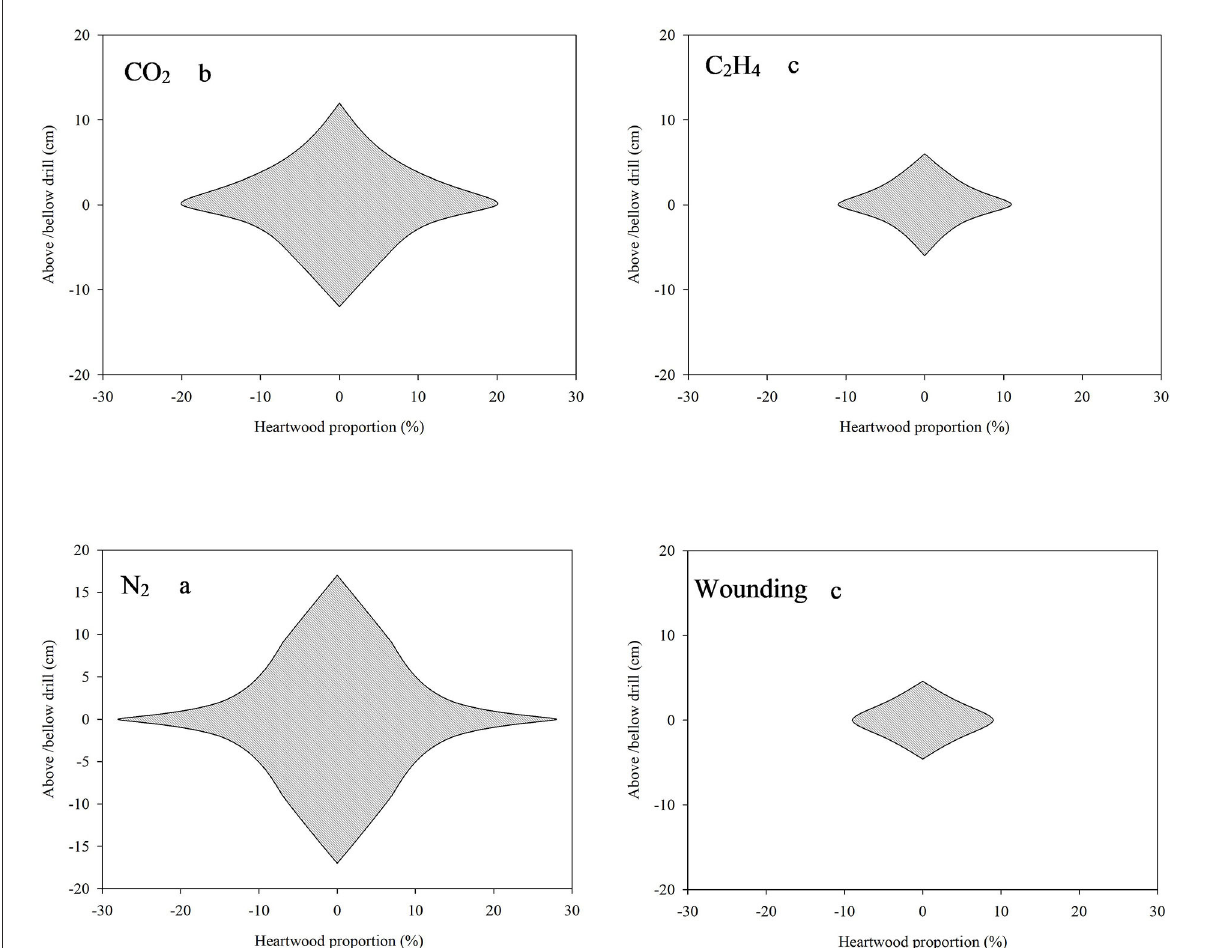
FIGURE3 Longitudinal and radial extension of heartwood induced by different gas treatments. Longitudinal extension is expressed as the distance above/below the drill hole (cm), and radial extension proportion is expressed as the width of induced heartwood relative to the whole wood (%). Different letters indicate significant differences at p < 0.05.